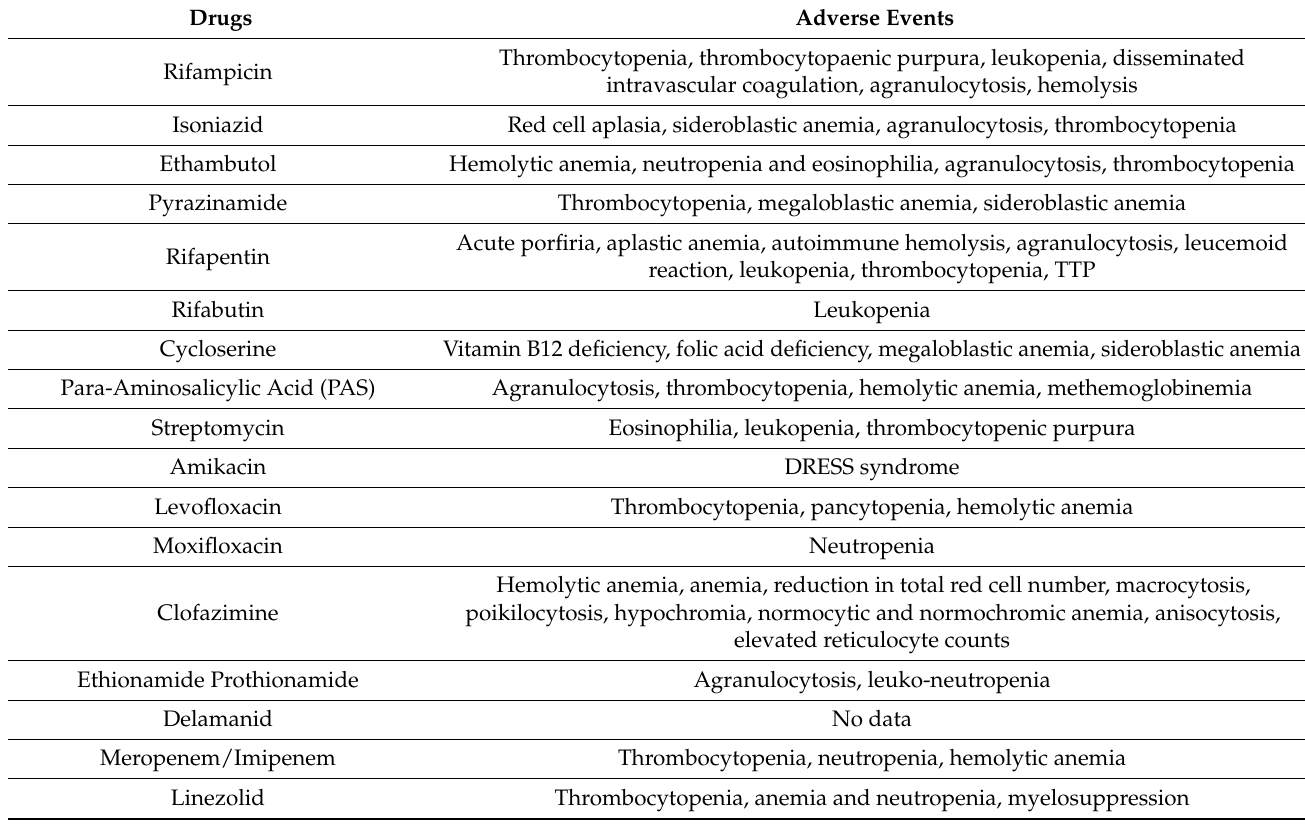
Table 2. Common and rare hematologic adverse event due to TB